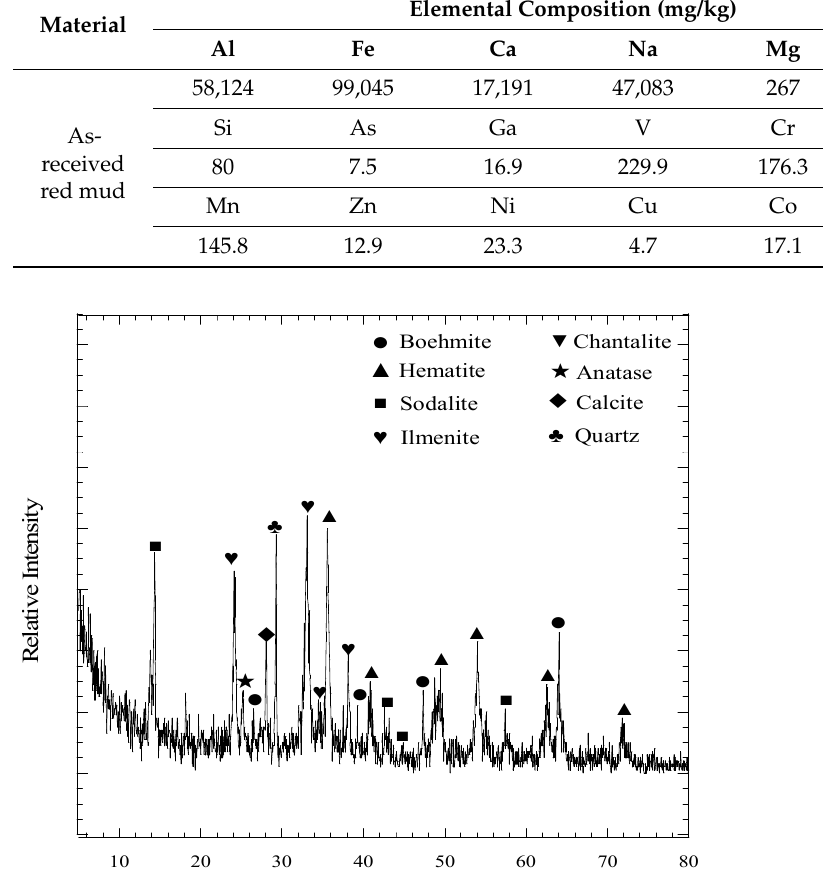
Figure 1. Results of XRD analysis for the as-received red mud.